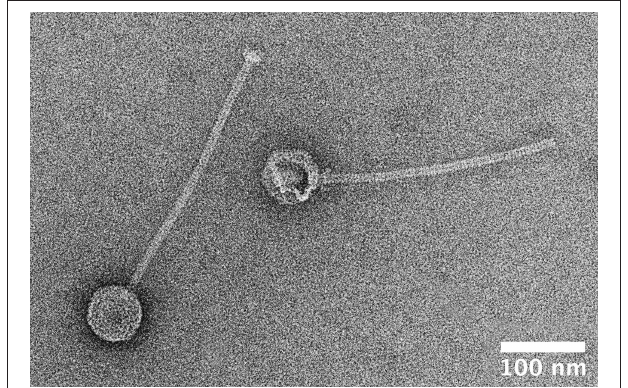
FIGURE 8 | Transmission electron microscopy image of negatively stained particle of phage ϕ MC1 induced from Macrococcus caseolyticus subsp. hominis subsp. nov. CCM 7927 T by UV-light.